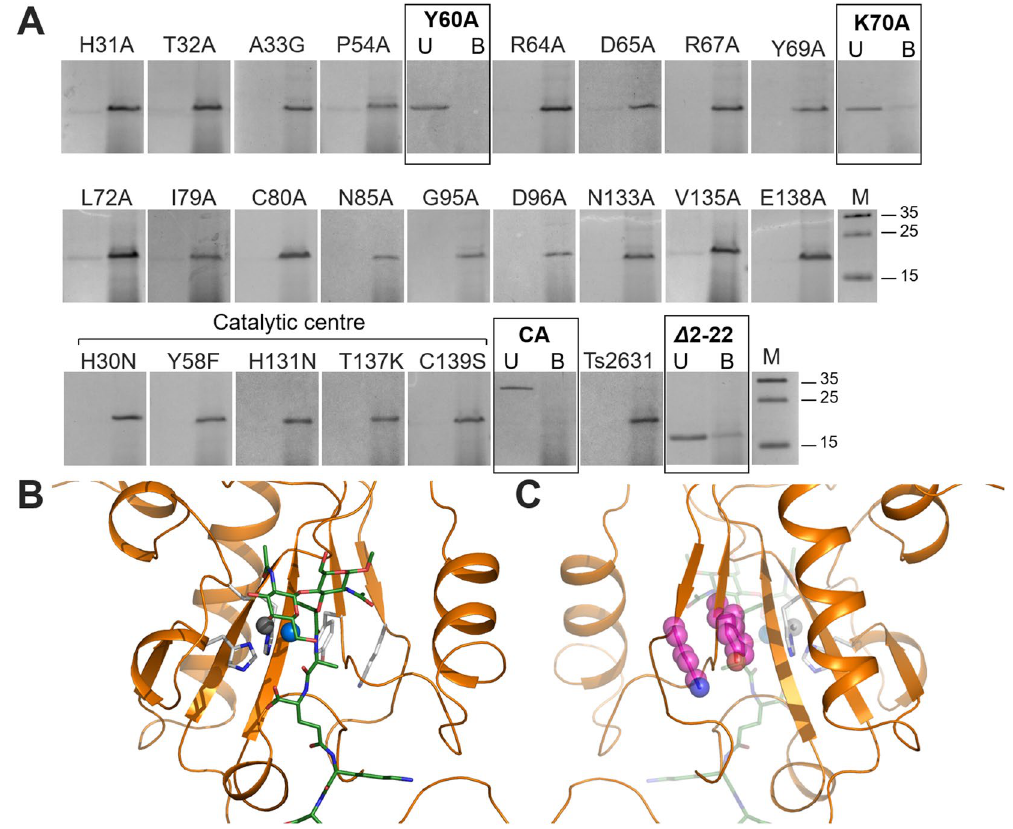
Figure 7. Evaluation of peptidoglycan binding activity of the Ts2631 endolysin variants. ( A ) Ts2631 endolysin variants were mixed with purified T. thermophilus HB8 peptidoglycan, and the proteins remaining in the supernatant ( U , unbound) or bound to peptidoglycan ( B , bound) were separated by centrifugation at 12,600 × g for 5 min at 4 °C. Proteins were analyzed by SDS-PAGE. Wild-type Ts2631 endolysin and carbonic anhydrase (CA) were used as positive and negative controls, respectively. Frames indicate proteins predominant in the supernatant fraction, namely, Y60A, K70A, the negative control (CA) and the Ts2631 endolysin truncated derivative Δ 2-22. M - PageRuler prestained protein ladder, 10 to 180 kDa (Thermo Fisher Scientific). ( B ) The front side of the PGN-binding groove. ( C ) The back side of the PGN-binding groove with residues Tyr60 and Lys70 highlighted in